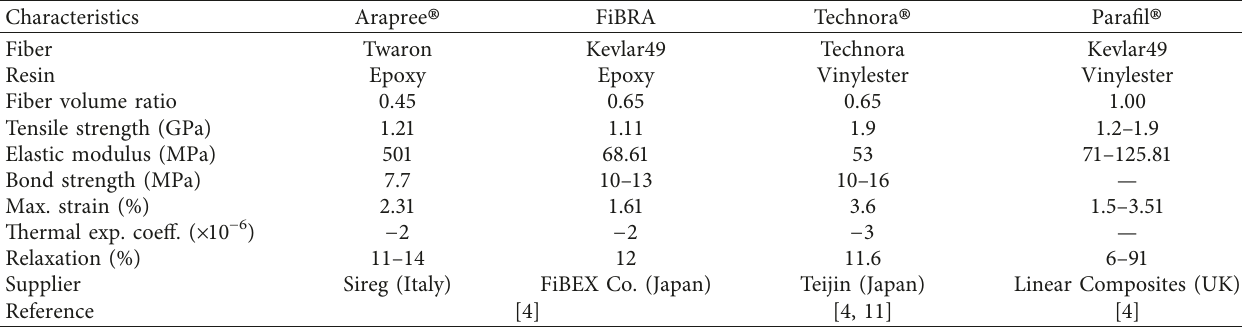
Table 1: Commercialized AFRP